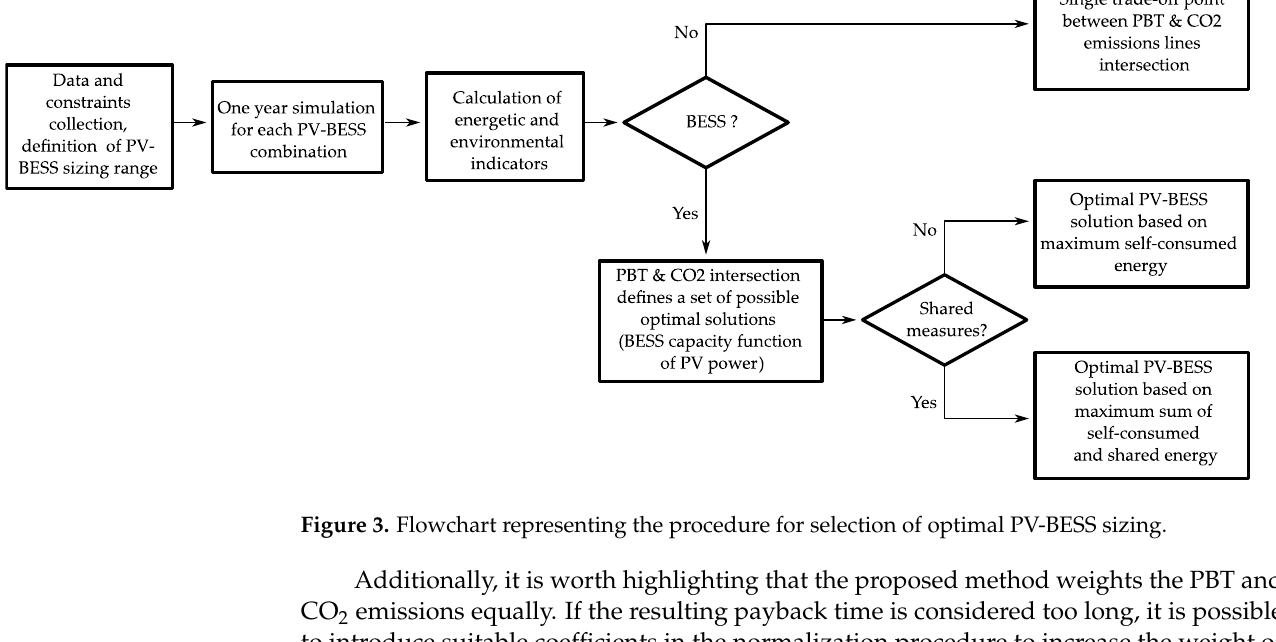
Table 6. Considered simulation scenarios.